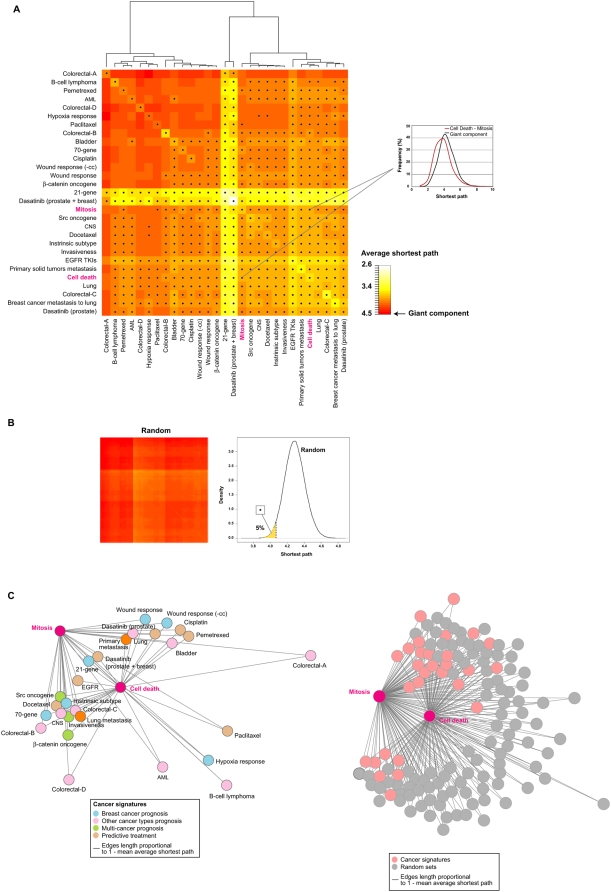
Proximity between gene products of signatures in the interactome network.
A, heat map of average shortest paths between proteins encoded by signatures. This analysis was performed using only the giant network component. An example of shortest path differences with respect to the giant component is shown in the right panel for the comparison between the complete Cell Death and Mitosis GO sets. B, heat map of comparisons of 1,000 randomly selected 50-protein sets in the giant component. Right panel, density plot of average shortest path in randomly selected sets: the 5% lower values are highlighted, which correspond to an average shortest path <4.09. Comparisons between signatures below this empirical cut-off are shown by dots in A. C, left panel, network representation of average shortest paths between Cell Death and Mitosis and cancer signatures as shown in the inset. Edges lengths are proportional to the average shortest path values. Right panel, network representation of average shortest paths between Cell Death and Mitosis and cancer signatures or randomly selected protein sets with equivalent degree centrality.